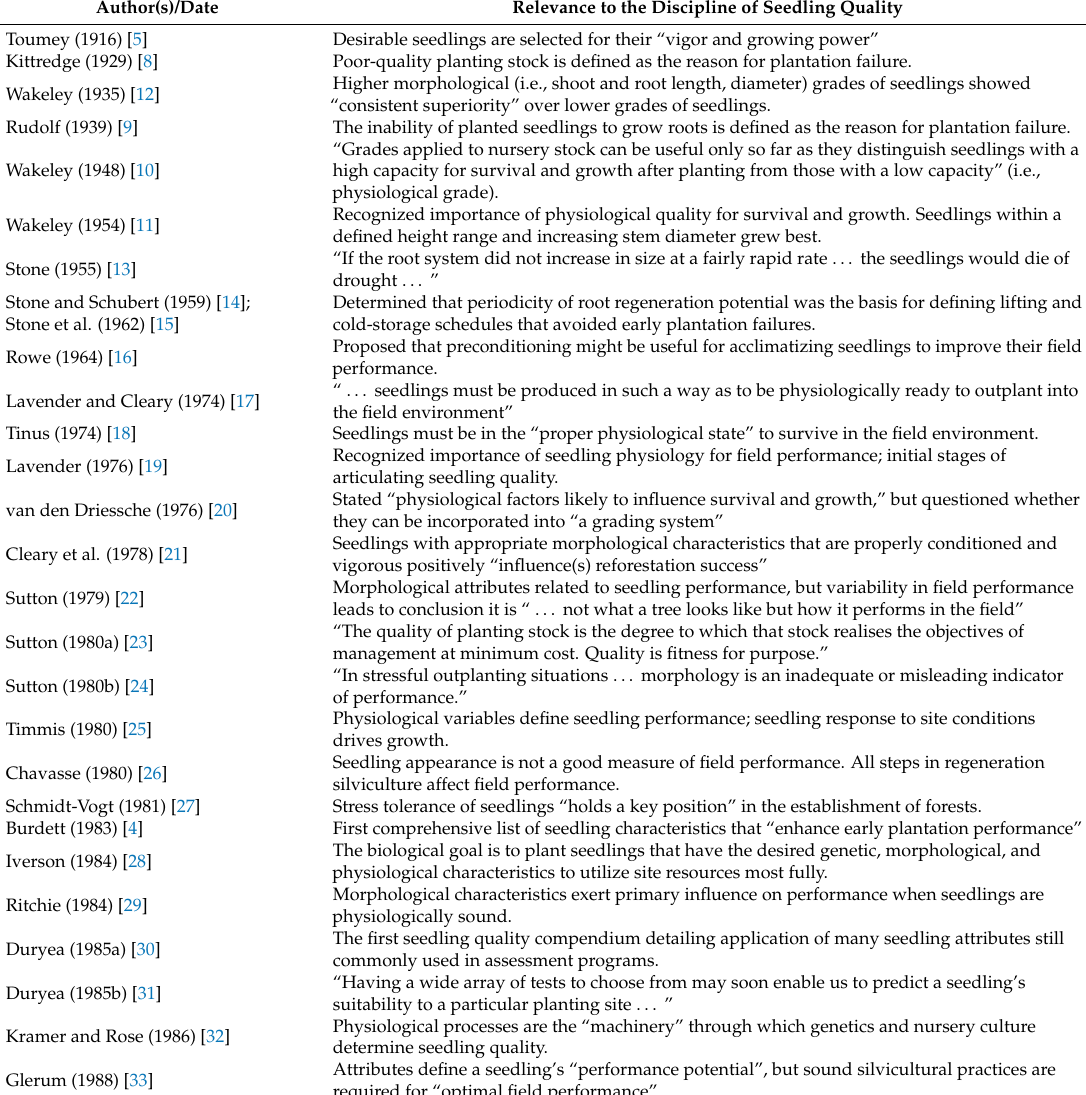
Table 1. A chronological list of references that discuss seedling quality, review seedling quality issues, or provide conceptual ideas related to seedling survival and/or growth after